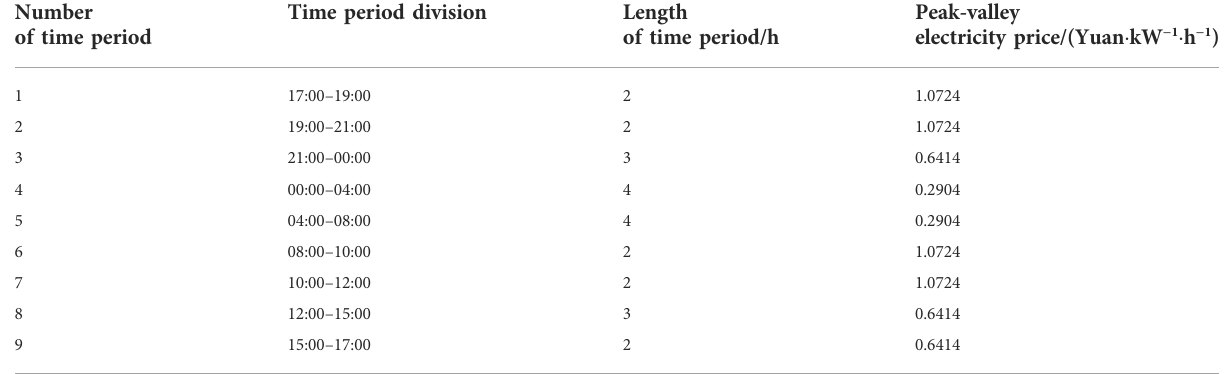
TABLE 1 Time period division and corresponding peak-valley electricity price during water-logging drainage process. Number of time period